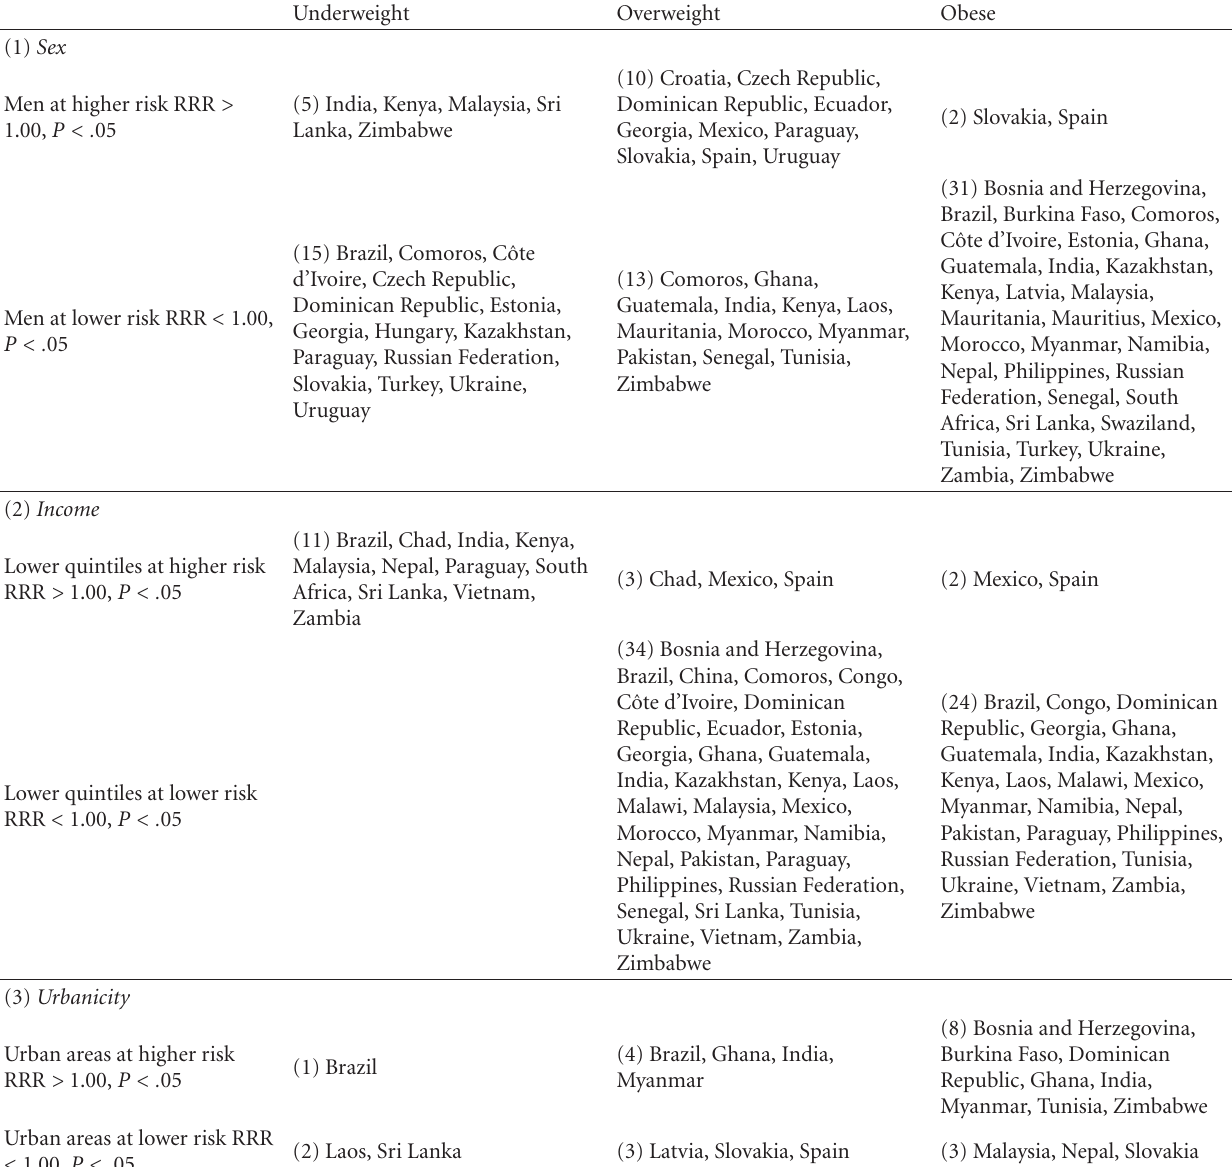
Table 4: Summary results for countries with adjusted relative risk ratios (RRRs) and 95% Confidence Interval (CI) with P < . 05 from multinomial multivariable models regressing BMI classification on sex, age, income, and urbanicity, WHS, 2002-2003. Underweight Overweight